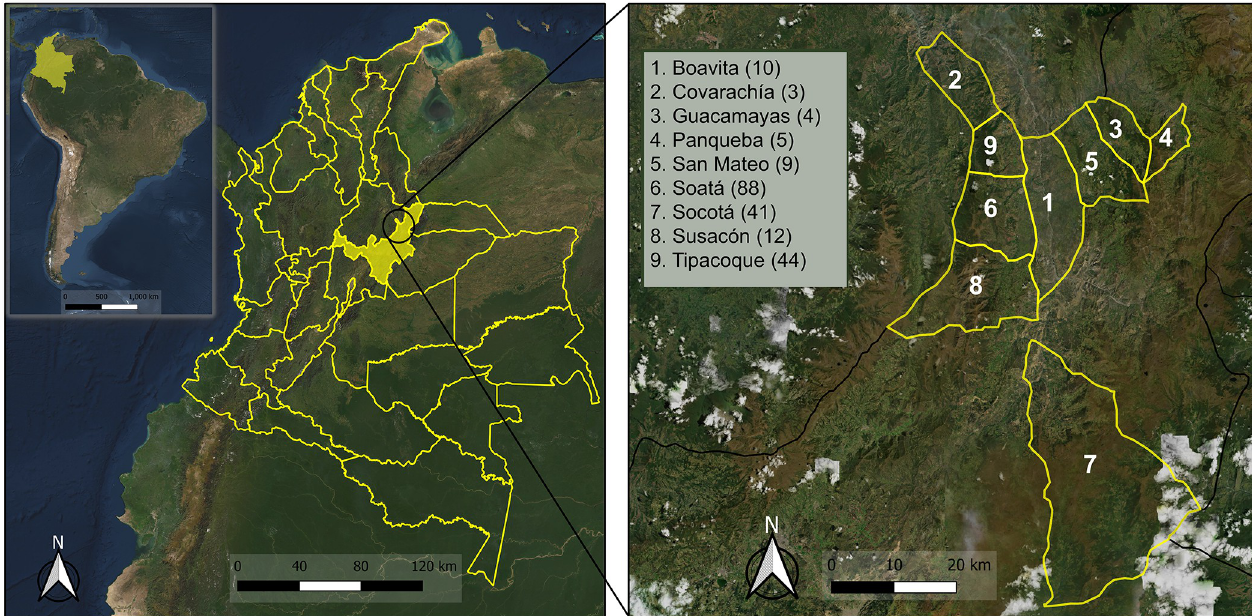
Fig 1. Geographical distribution of collection sites. The map on the left was made with ArcGIS Online [31] (Basemap: Elevation/World_Hillshade https://bit. ly/3vVQ1lL; Sources: Esri, Airbus DS, USGS, NGA, NASA, CGIAR, N Robinson, NCEAS, NLS, OS, NMA, Geodatastyrelsen, Rijkswaterstaat, GSA, Geoland, FEMA, Intermap and the GIS user community). The map on the right was made with QGIS 3.22 (Basemap: Esri Satellite World_Imagery (MapServer) https:// bit.ly/3MRtYCf; Sources: Esri, Maxar, Earthstar Geographics, and the GIS User Community; CC BY-SA 3.0) and shows a satellite view of the northern region of Boyaca´, Colombia, where the nine municipalities are highlighted in yellow and indicated with numbers. The legend shows the respective municipality and the number of samples collected.